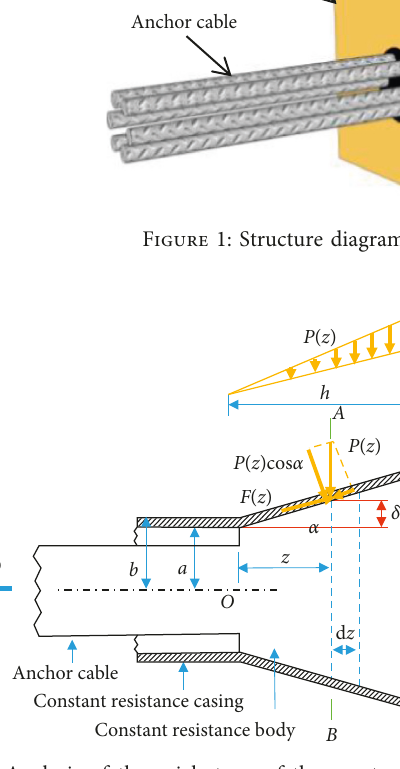
Figure 2: Analysis of the axial stress of the constant resistance